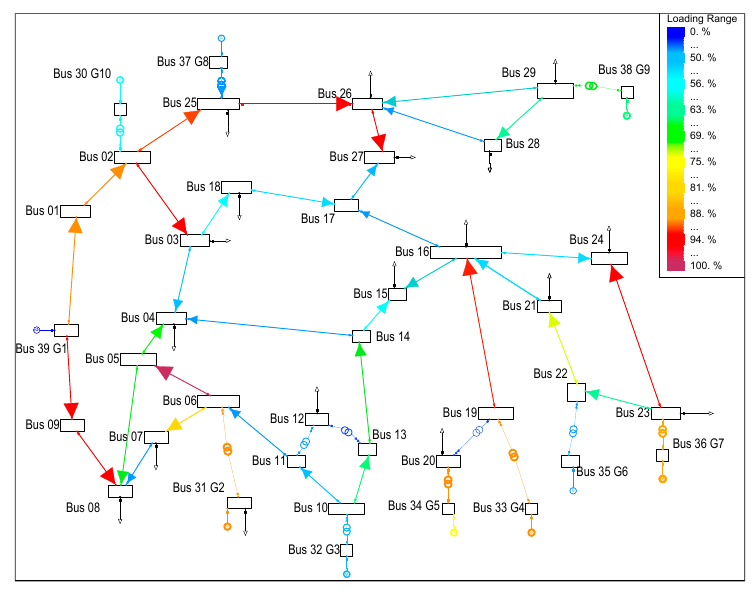
Figure 5. Maximum loadability with N − 1contingencies.